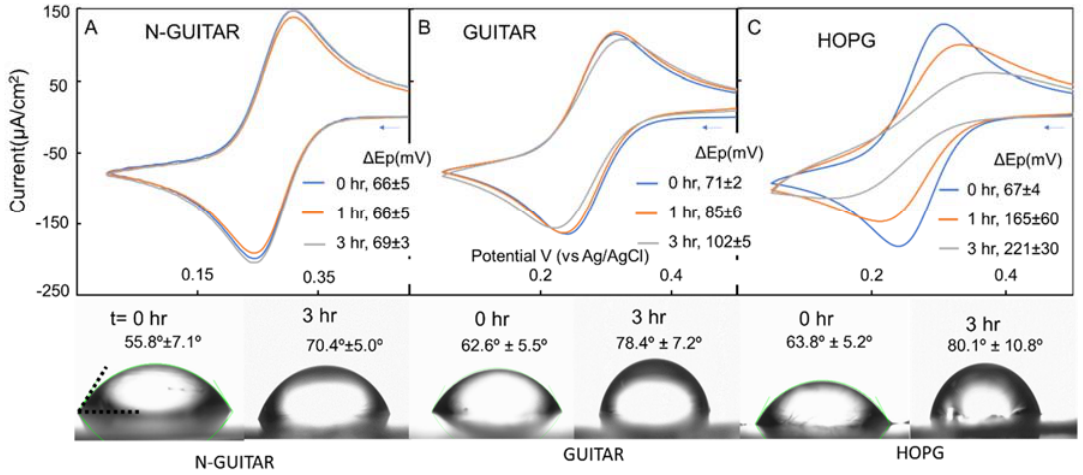
Figure 8. Cyclic Voltammetric (CV) studies for the N-GUITAR ( A ), GUITAR ( B ) and HOPG ( C ) electrode with 1 mM Fe (CN) 63 − / 4 − in 0.1 M KCl at 50 mV / sec. CV were recorded in freshly exfoliated surface at 0, 1, and 3 h of air exposure (n = 3). Water contact angle measurement (WCA) on N-GUITAR, GUITAR and HOPG are also shown on their respective positions. WCA measurements were also carried out on freshly exfoliated surfaces at 0, 1, and 3 h of air exposure.